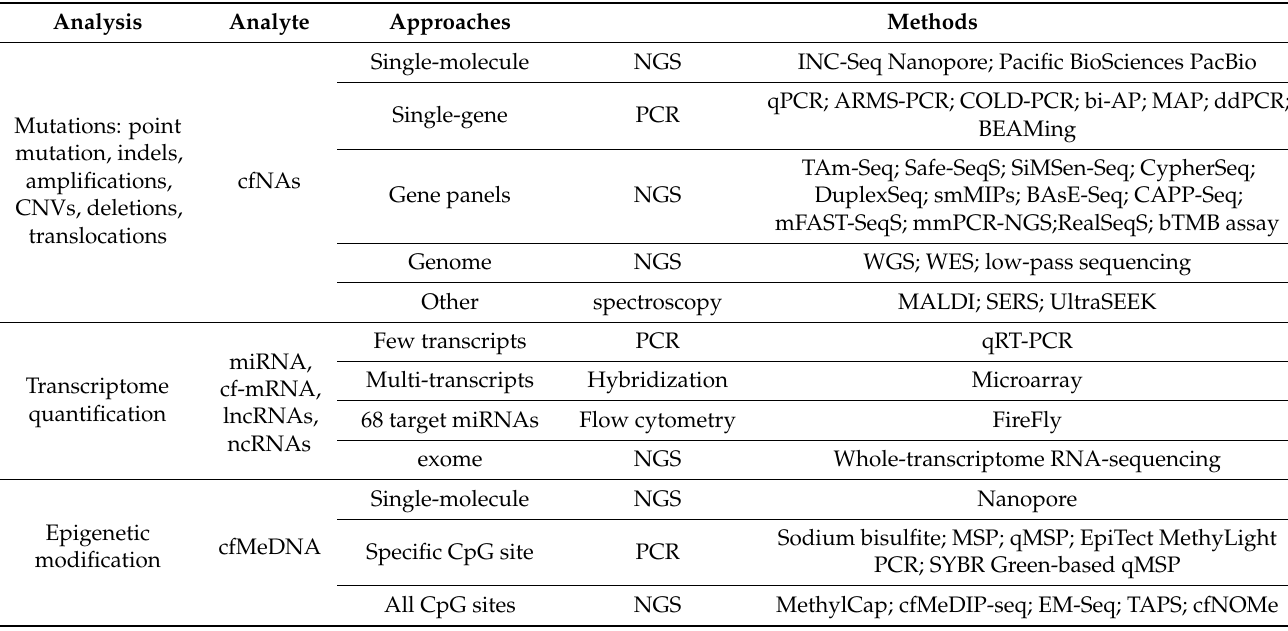
Table 2. Summary of cfNAs technical applications and methods of